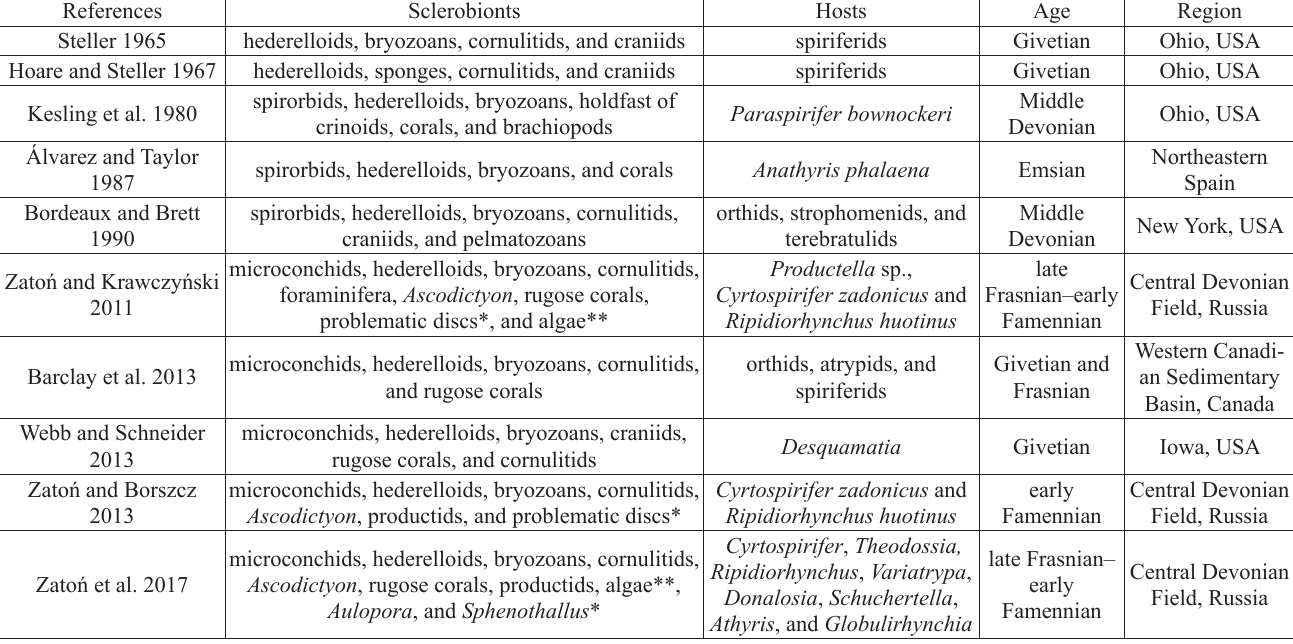
Table 1. Devonian records of the interaction sclerobionts/brachiopods. * represents the same taxon according to Zatoń et al. (2017); ** algae from the genus Rothpletzella according to Zatoń and Jarochowska (2020).